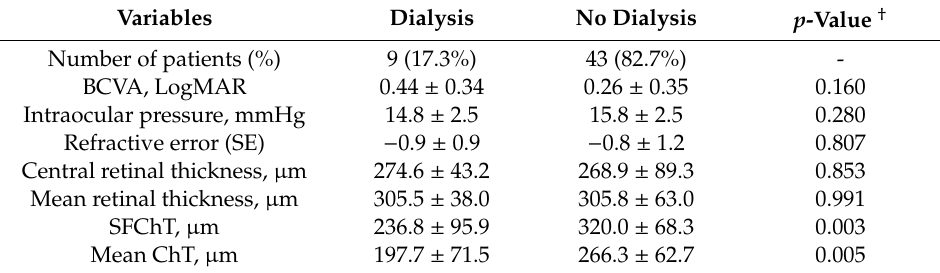
Table 4. Comparison of ocular parameters of treatment-naïve proliferative diabetic retinopathy patients who underwent hemodialysis and that of those that did not undergo hemodialysis. Variables Dialysis No Dialysis p -Value † Number of patients (%) 9 (17.3%) 43 (82.7%) - BCVA, LogMAR 0.44 ± 0.34 0.26 ± 0.35 0.160 Intraocular pressure, mmHg 14.8 ± 2.5 15.8 ± 2.5 0.280 Refractive error (SE) − 0.9 ± 0.9 − 0.8 ± 1.2 0.807 Central retinal thickness, µ m 274.6 ± 43.2 268.9 ± 89.3 Mean retinal thickness, µ m 305.5 ± 38.0 305.8 ± 63.0 236.8 ± 95.9